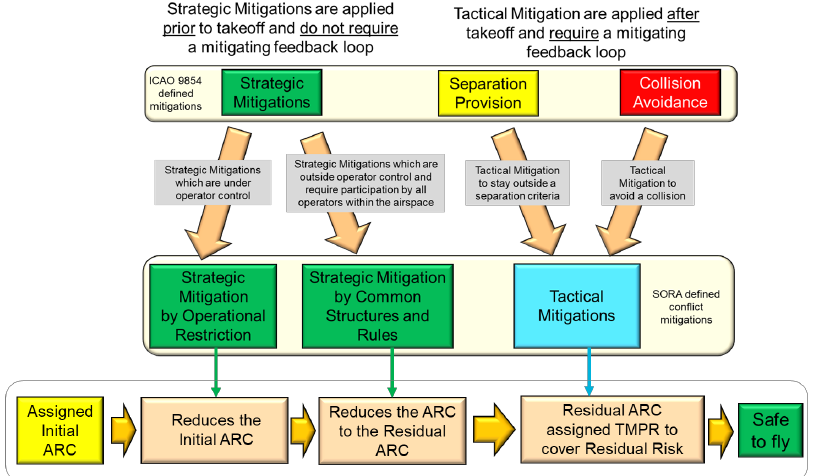
Figure 5. SORA air-conflict mitigation process. Reprinted with permission from [30]. Copyright (2019)